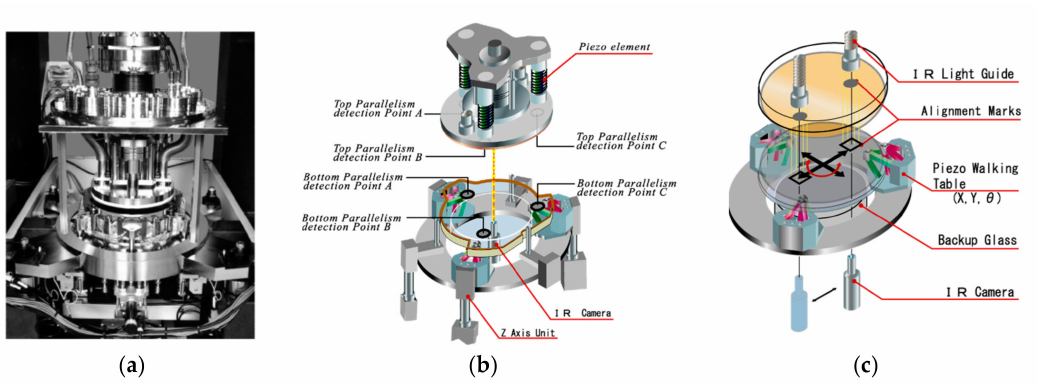
Figure 7. The aligned wafer bonding system used in this study: ( a ) photograph, the schematic diagrams of ( b ) the parallel adjustment and ( c ) the infrared (IR) alignment